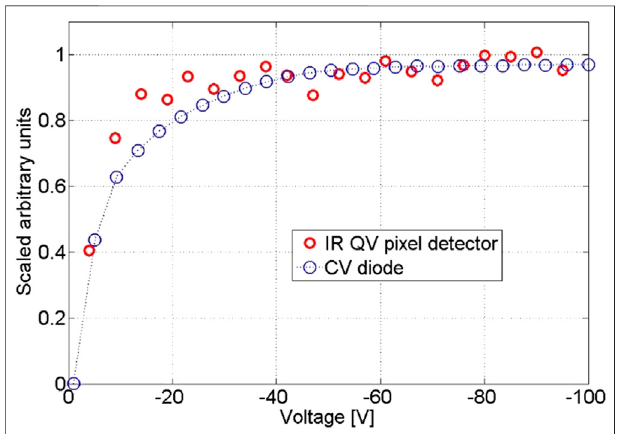
FIGURE 7 | IR 1060 nm laser TCT measurement (red) and 1/C 2 (blue) showing the voltage saturation point. The detector full depletion voltage V fd in both cases is about – 60